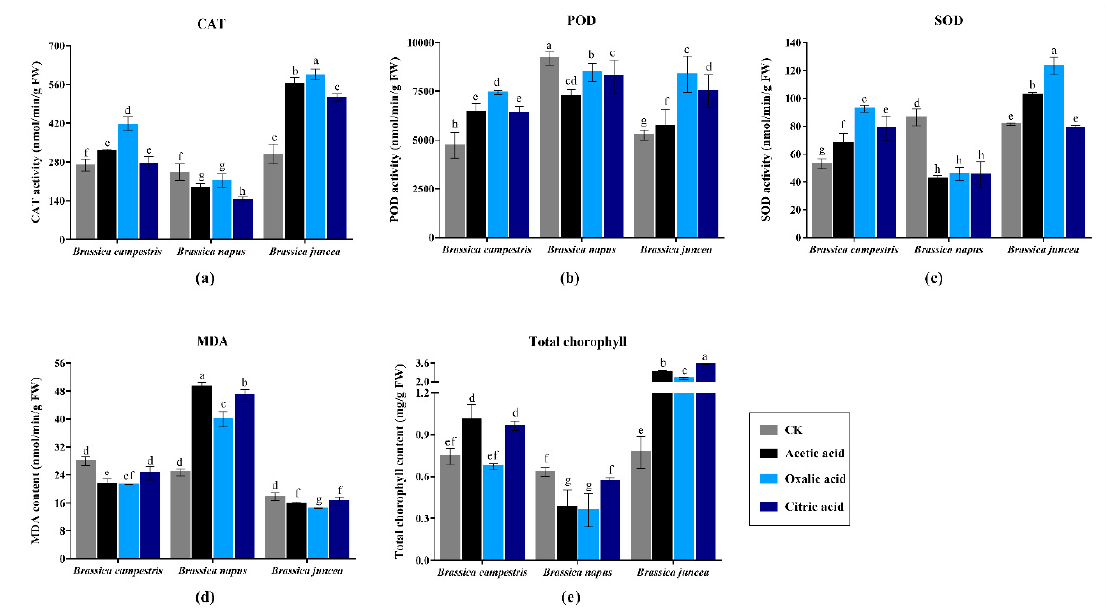
Figure 4. The antioxidant system in three Brassica species under 20 mg/kg Cd stress. The Values are means ± SE from three biological replicates. Values followed by different letters indicate statistical significance based on two-way ANOVA ( p < 0.05). ( a ) Catalase CAT activity. ( b ) Peroxidase POD activity. ( c ) Superoxide dismutase SOD activity. ( d ) Malondialdehyde MDA content. ( e ) Total chlorophyll content.